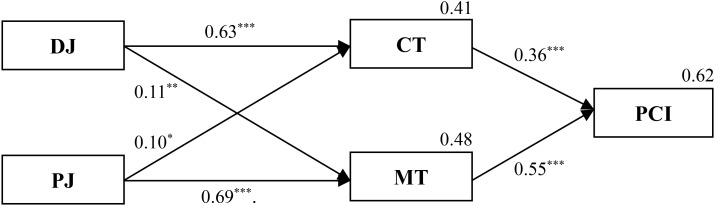
The dual-pathway model of public cooperation intention. n = 165; ∗∗∗p < 0.001, ∗∗p < 0.01, ∗p < 0.05. Model fit indices: χ2 = 3.01, df = 3, p = 0.39; CFI = 1.00, NFI = 1.00, RMSEA < 0.01.